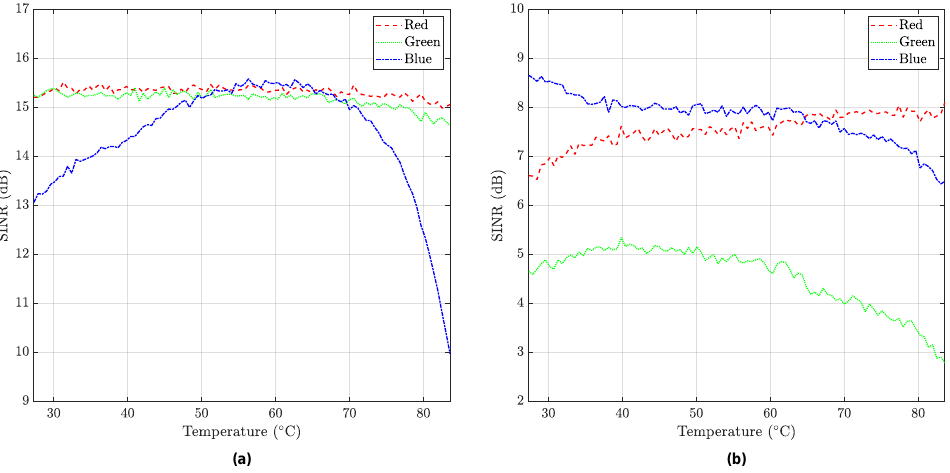
Figure 12. SINR at different temperatures, compensating the channel using the CSI corresponding to 60°C and with a medium SNR value (20 dB). ( a ) Sony IMX249 and ( b ) Foveon X3. Dashed line, dotted line, and dash-dot line correspond to red, green, and blue,